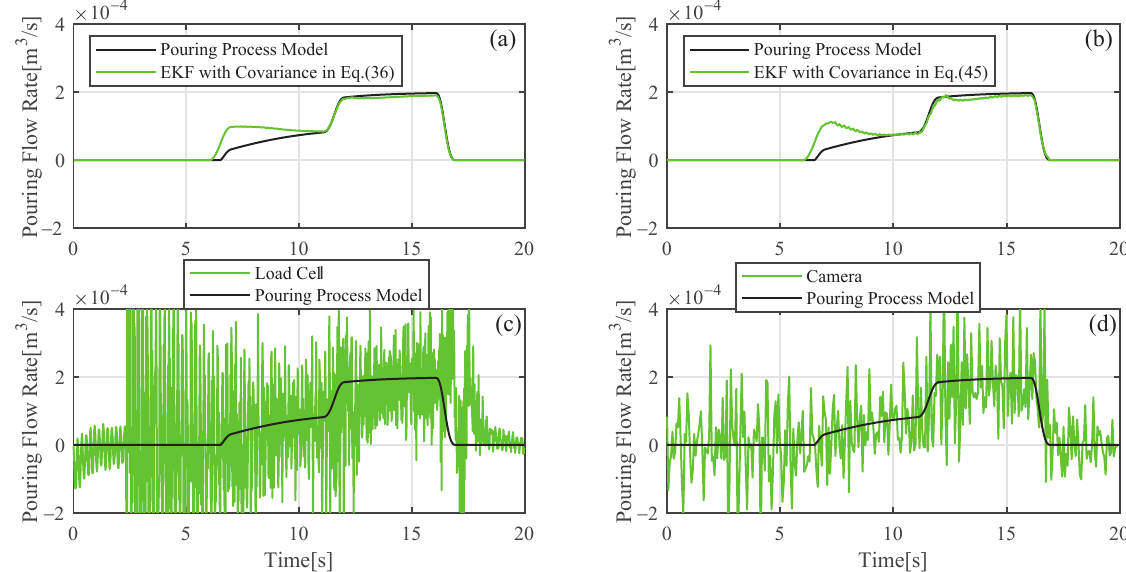
Figure 20. Comparison of flow-rate estimations in experiments with tilting angle error at the start of liquid outflow: + 3 deg. ( a ) Estimated flow rate by EKF with covariance as shown in Equation (37); ( b ) Estimated flow rate by EKF with covariance as shown in Equation (46); ( c ) Estimated flow rate by differentiating weight of outflow liquid measured by load cell; ( d ) Estimated flow rate by visible